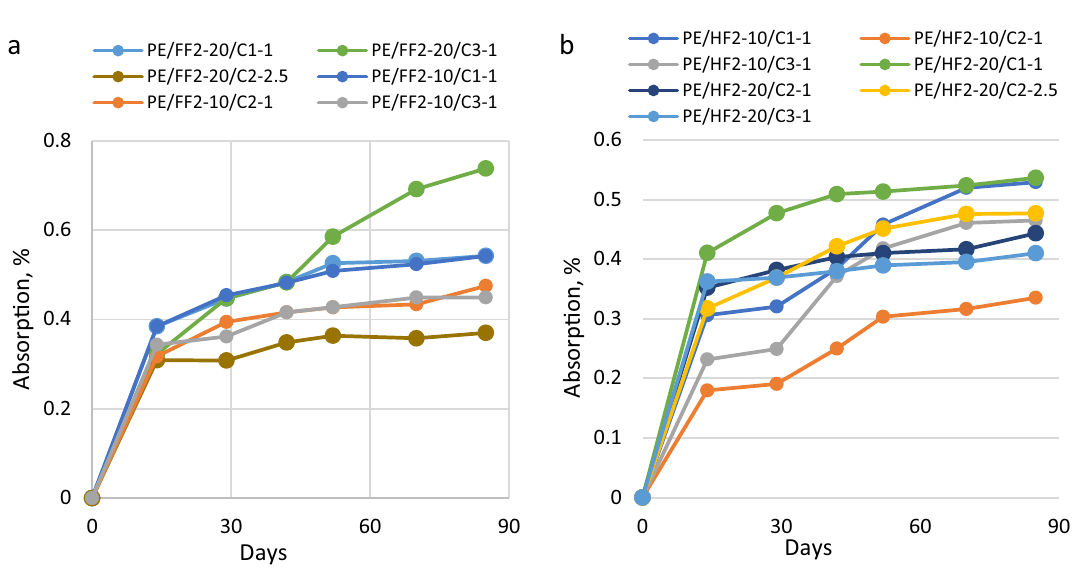
Figure 5. Moisture sorption bio-PE composites with flax or hemp fibers, at 100%